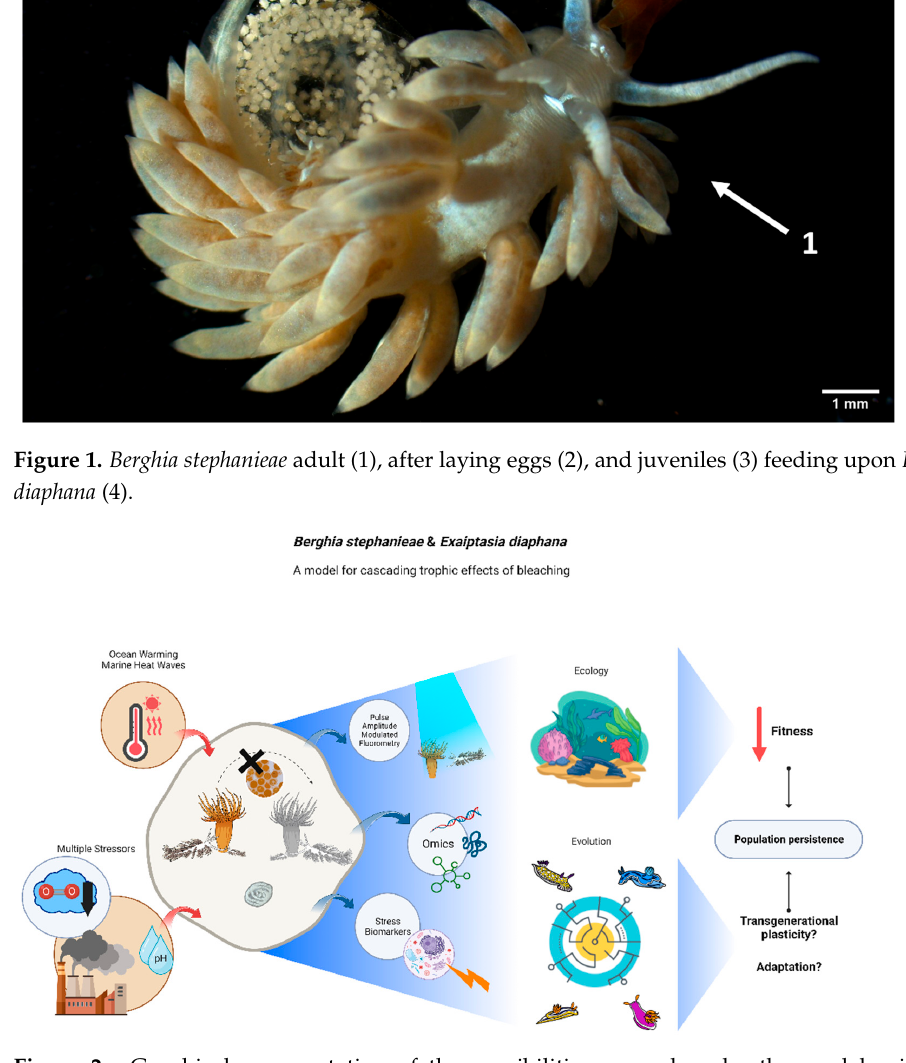
Figure 2. Graphical representation of the possibilities opened-up by the model-pair Berghia stepha- nieae/Exaiptasia diaphana for research on cascading trophic effects of bleaching, from molecular to ecosystem level. Blue arrows represent available methodologies to advance the state of the art and red arrows indicate environmental stressors to be addressed. Central part of the figure displays the different conditions on which one can study this model-pair: sea slug adults and juveniles feeding on symbiotic anemones and sea slug adults and juveniles feeding upon bleached anemones, and their egg masses. The right part of the image displays expected outcomes from this subpar feeding regime.